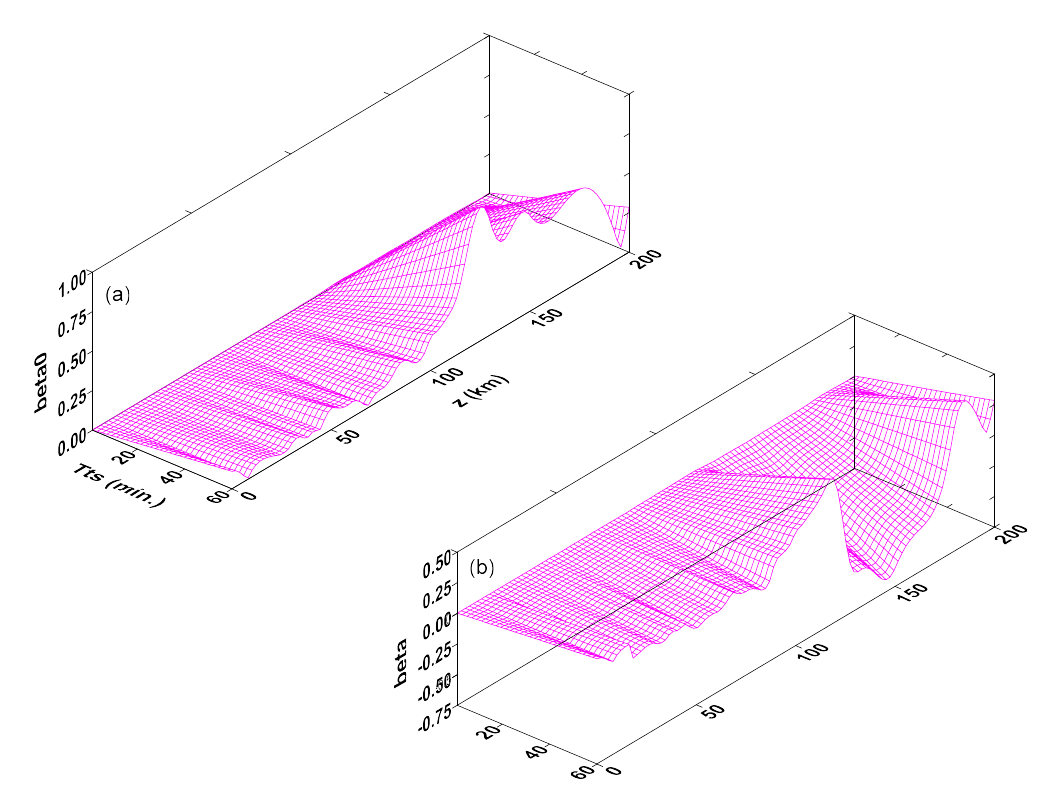
Figure 6. Contours of the “damping factor”, β (or, alternatively, the error, E ) versus T ts and z . ( a ) special case with θ = 0; and ( b ) generalized case with θ (cid:54) =